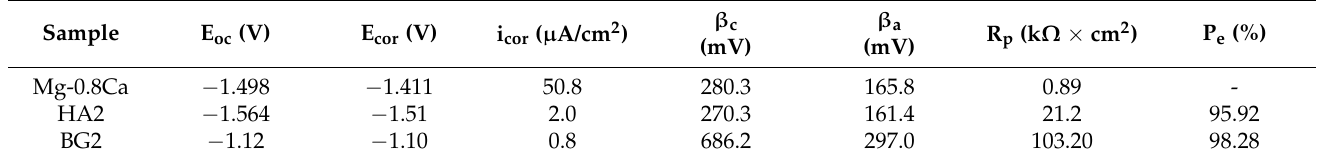
Table 2. The main parameters of the electrochemical corrosion process in DMEM.